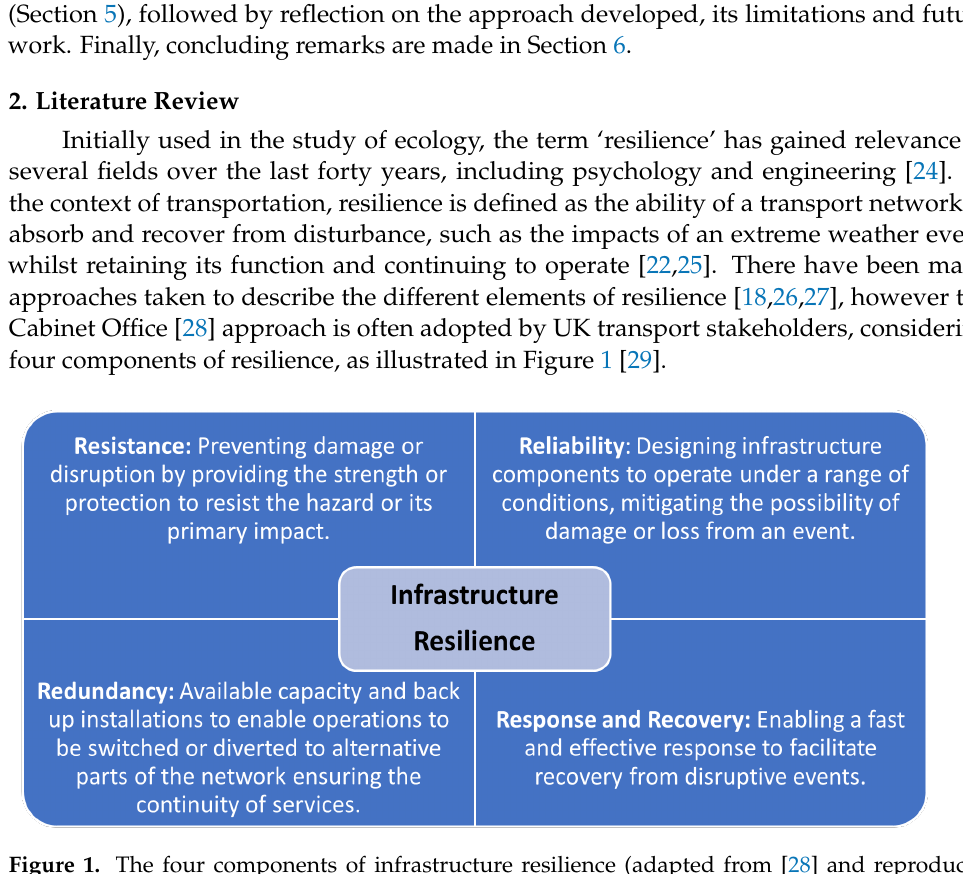
Figure 1. The four components of infrastructure resilience (adapted from [28] and reproduced from [29] with the author’s permission).